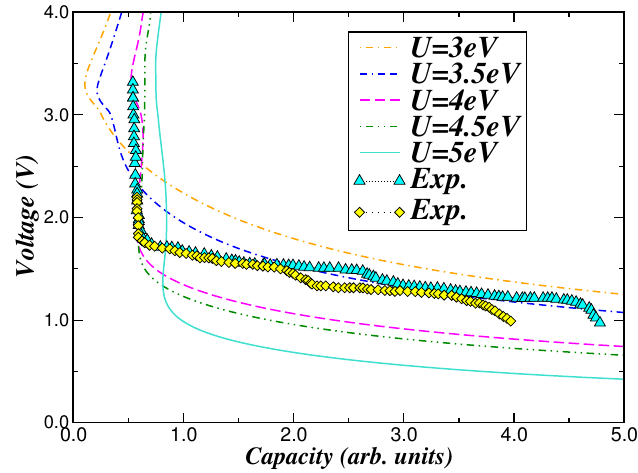
Figure 6. Rate capability of stoichiometric MoO 2 within LDA+DMFT in the potential ( V ) window relevant for future battery applications. Experimental voltage-capacity profiles of MoO 2 taken from Refs. [27] (triangles) and [16] (diamond) are shown for comparison. (The experimental data was shifted upward to coincide with theory at low specific capacities.) Notice the good qualitative agreement between the experimental data and the LDA+DMFT results for U = 3.5